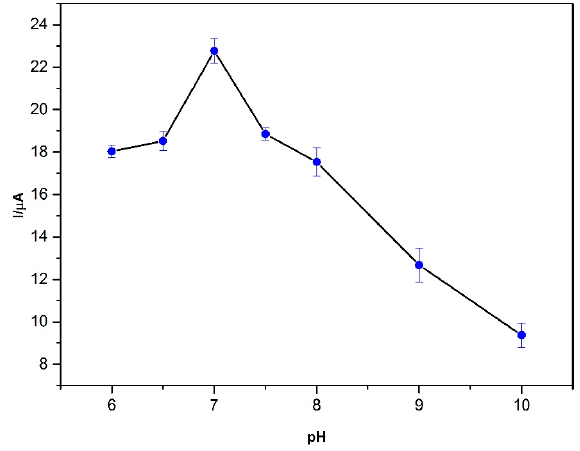
Figure 6. Effects of pH value on the current response of 5 μ M BPA. Conditions: pH 7.0; frequency: 50 Hz; step amplitude: 40 mV; pulse amplitude: 5 mV; E dep : − 0.2 V; t dep : 60 s.